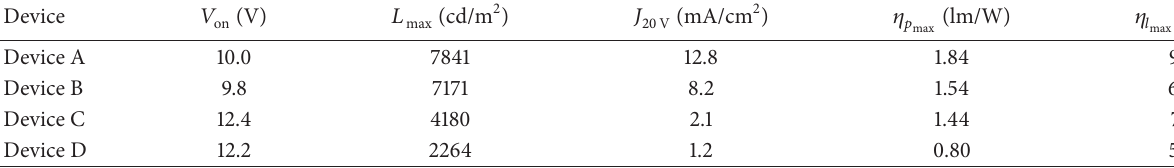
Table 1: Some detailed characteristics of four organic devices with different doping concentrations, including turn-on voltage, maximum luminance, current density at 20 V, maximum current, and power efficiency.